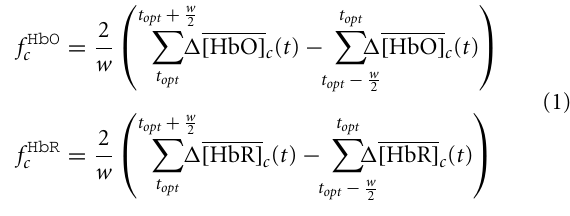
based on induced band power changes ( POW classifier) and the downsampled ERP waveform ( ERP